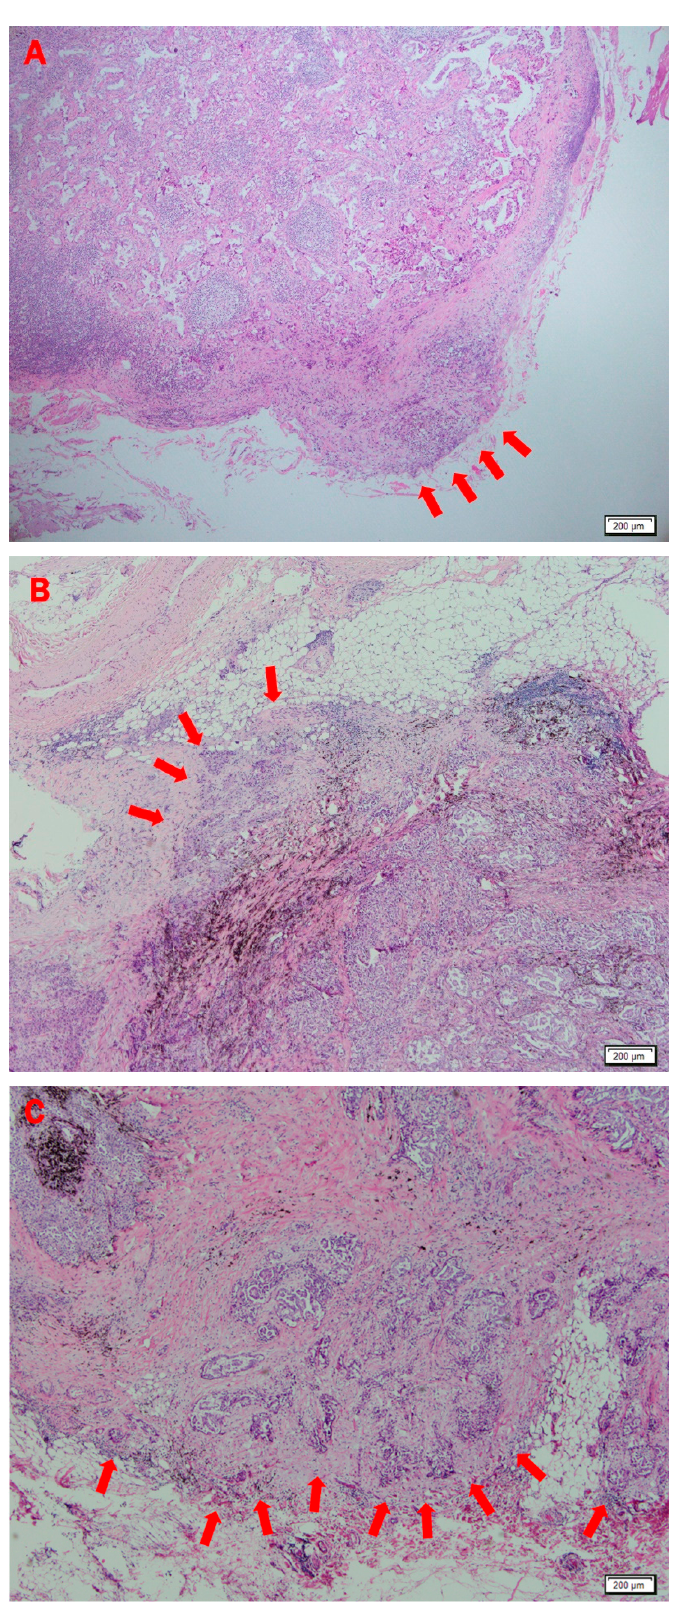
Figure 1. Histologic findings indicating extranodal extension (ENE) in lung adenocarcinoma (hematoxylin and eosin; ×40). Arrows denote ENE with cancer cells extending through the capsule of the lymph node, invading adjacent fatty tissue.